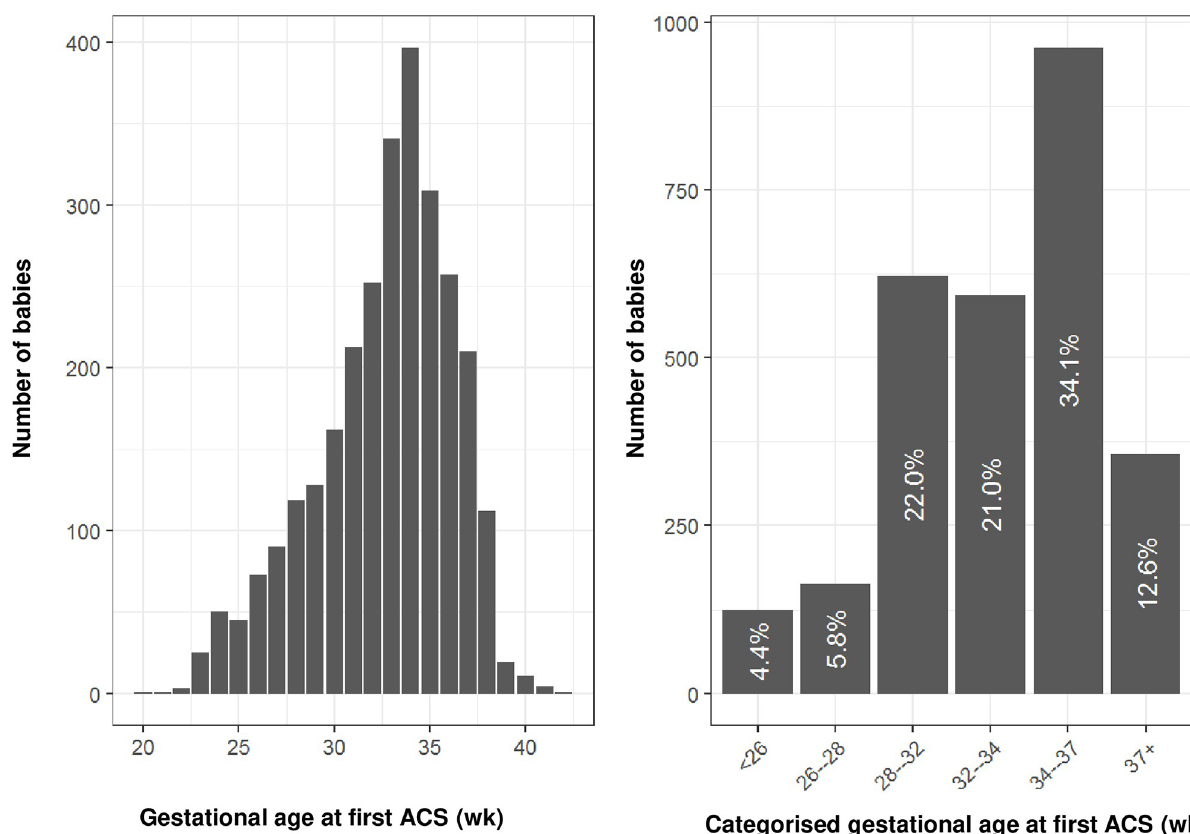
Fig 6. Gestational age at ACS administration (first dose) for subset of Scotland births in Aberdeen, and categorised by gestational age groups. (wk) = completed weeks of gestation.